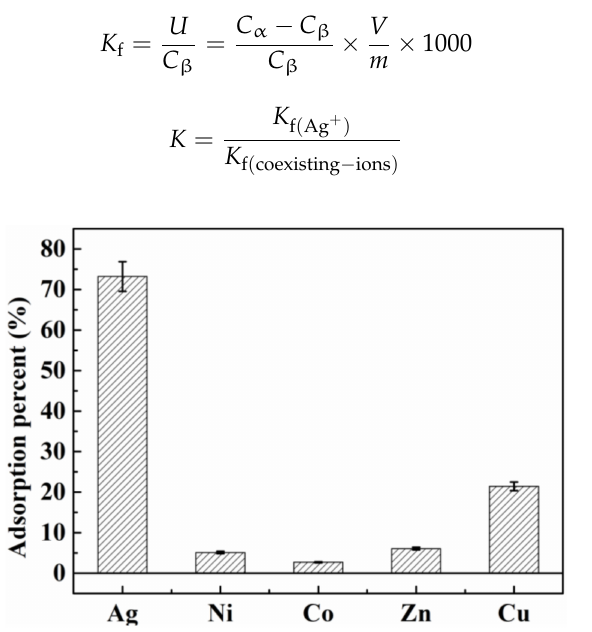
Figure 7. Effect of coexisting ion on the adsorption of Ag(I) by